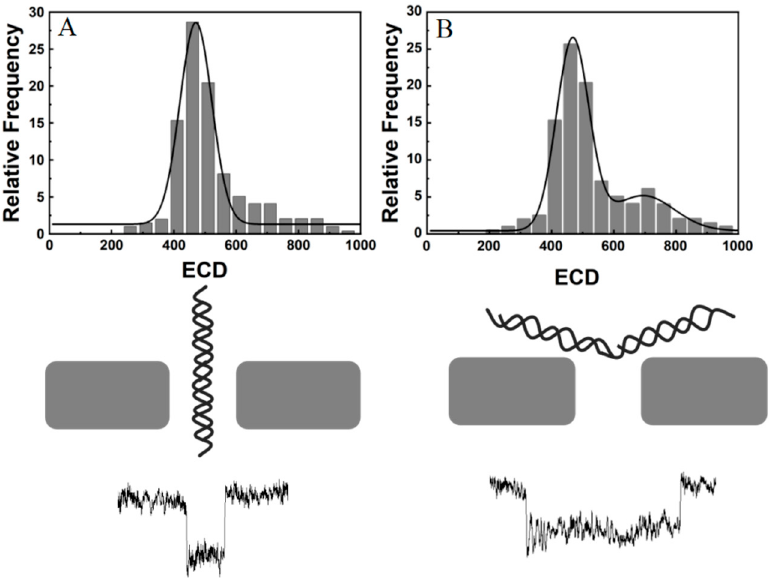
Figure 5. The ECD statistics of long DNA normal translocation through a nanopore ( A ) and plugging phenomenon mixed in translocation events in a nanopore ( B ).